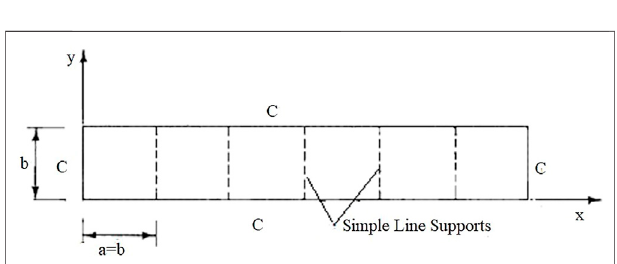
FIGURE10| Finite(6equalspan)2Dperiodiclinesupportedrectangular plate with fi xed edge boundary conditions.